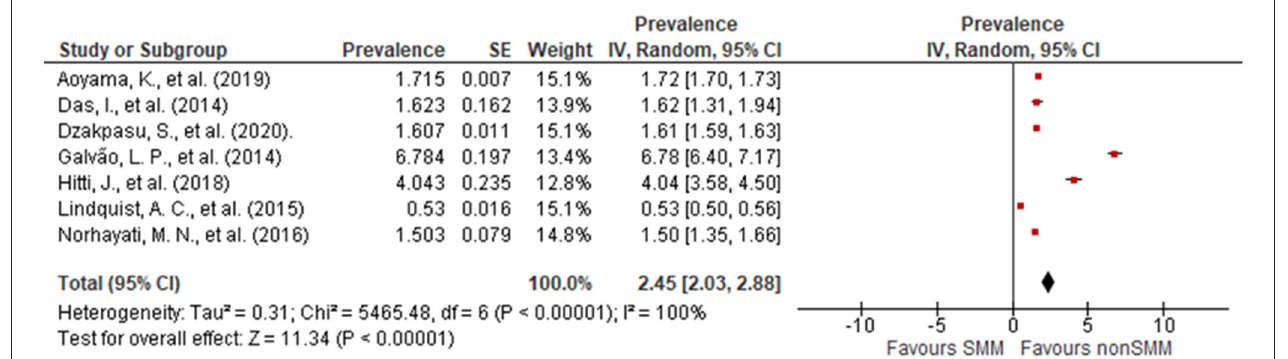
FIGURE 2 | Forest plot depicting the prevalence of severe maternal